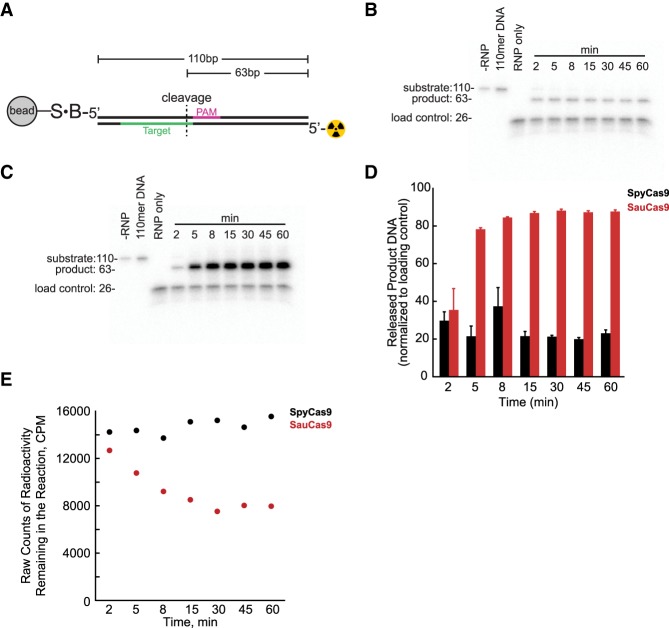
S. aureus Cas9 releases cleaved product DNA faster than S. pyogenes Cas9. (A) Cartoon illustrating the DNA1 substrate immobilized on a streptavidin magnetic bead, used for monitoring release of cleaved products in solution. S, streptavidin; B, 5′-biotin; radioactivity symbol, 5′-32P. The PAM-containing strand possessed a 5′-biotin and the non-PAM strand was labeled with a 5′-32P. DNA strands are color-coded the same as in Table 1: The PAM region (5′-TGGAAT) on the strand containing a 5′-biotin is in fuchsia and the target sequence (5′-ACAGTTCGATTAACTTTCAC) complementary to the sgRNAs, on the strand containing a 5′-32P, is in green. (B,C) Release of cleaved DNA product 63mer, over time, by (B) SpyCas9 and (C) SauCas9 resolved on a 15% TBE urea denaturing gel. (D) Quantification of released product in B,C normalized to a 26mer single-stranded DNA control oligo; (black bars) SpyCas9 RNP, (red bars) SauCas9 RNP. Data are the result of two experimental replicates and reported as mean ± average deviation. (E) Total radioactive signal remaining in the reaction from D, measured by liquid scintillation, with SpyCas9 (black circles) and SauCas9 (red circles).